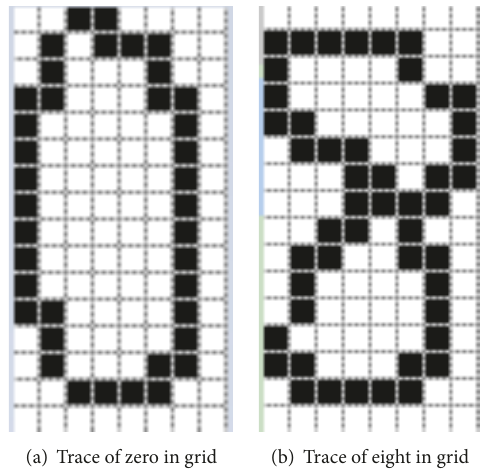
Figure 3: Illustration of grid-based feature extraction.